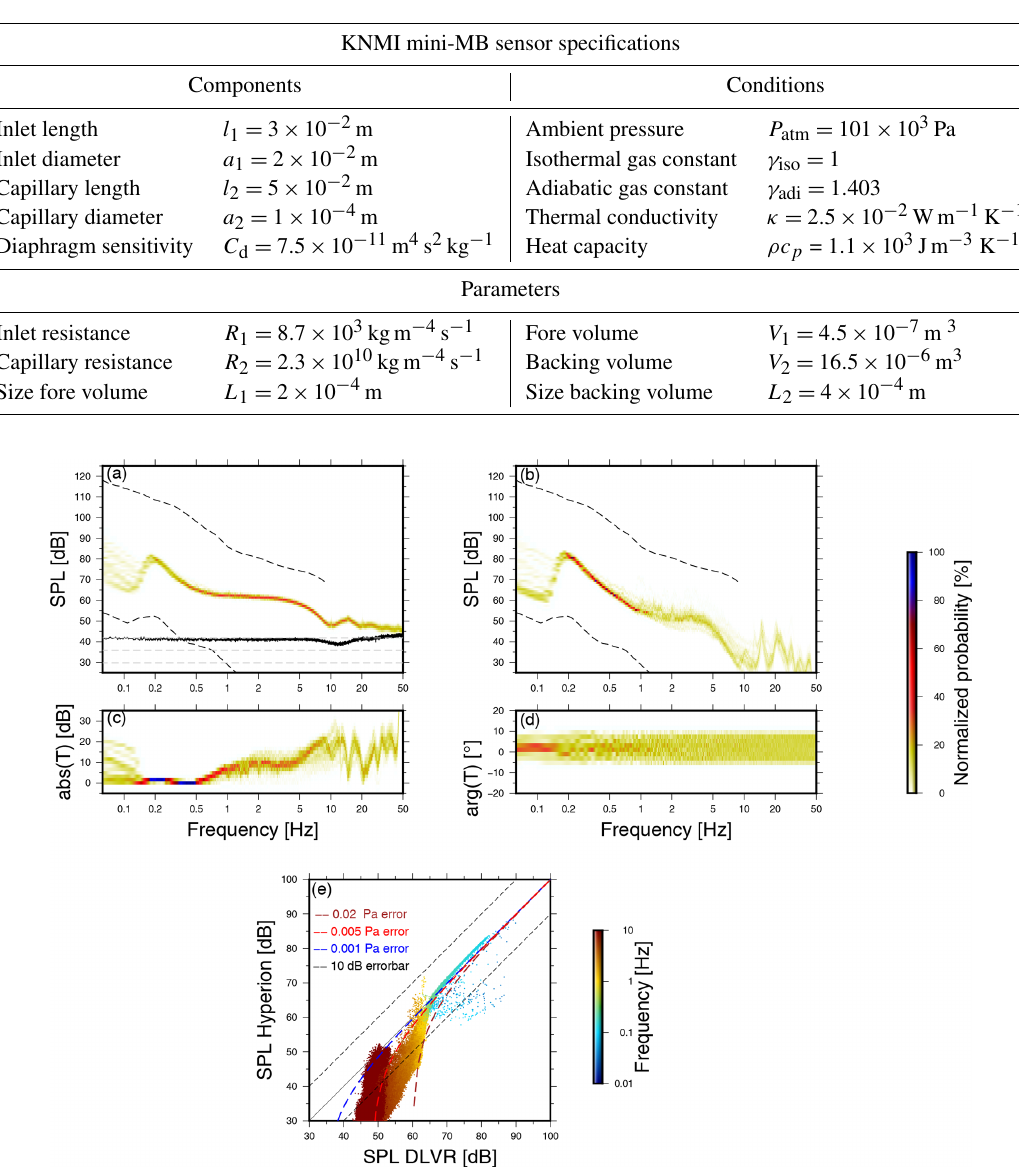
Table 1. KNMI mini-MB components, parameter values, and standard conditions used in the computations.